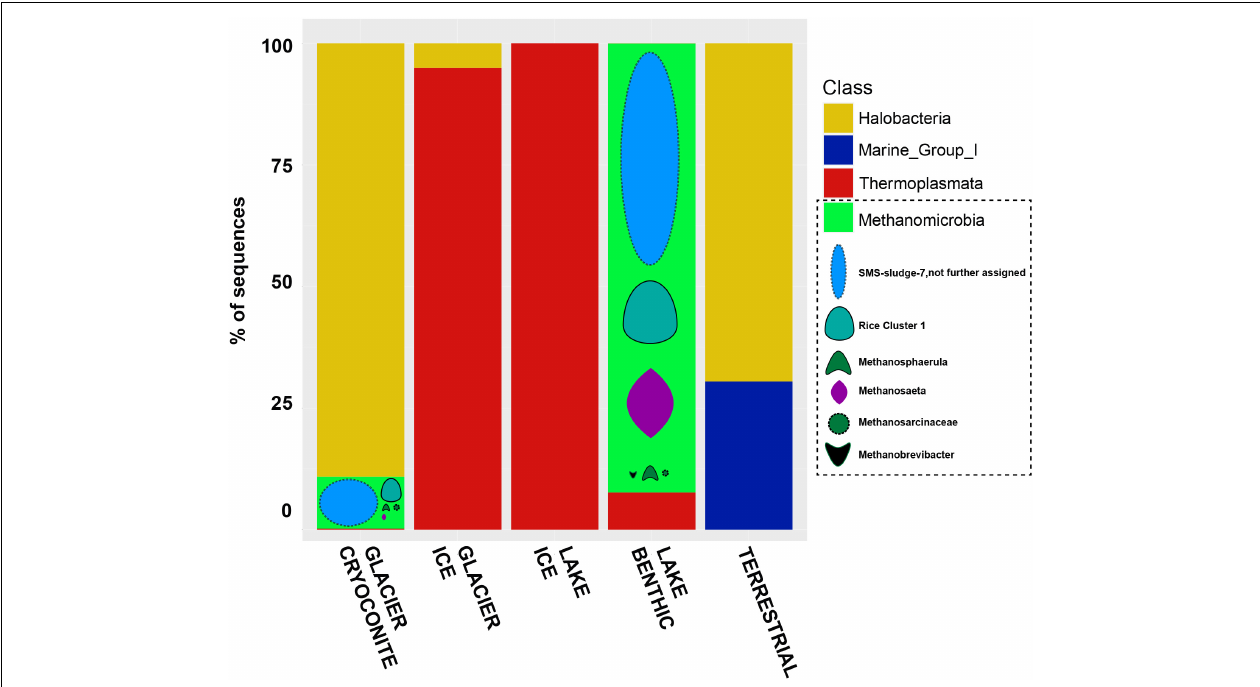
FIGURE 9 | Bar chart of archaeal sequences assigned to their respective habitats. Methanomicrobia are further classified into the groups SMS-sludge-7 , Rice Cluster 1 , Methanospaerula , Methanosaeta , Methanosarcinaceae , and Methanobrevibacter